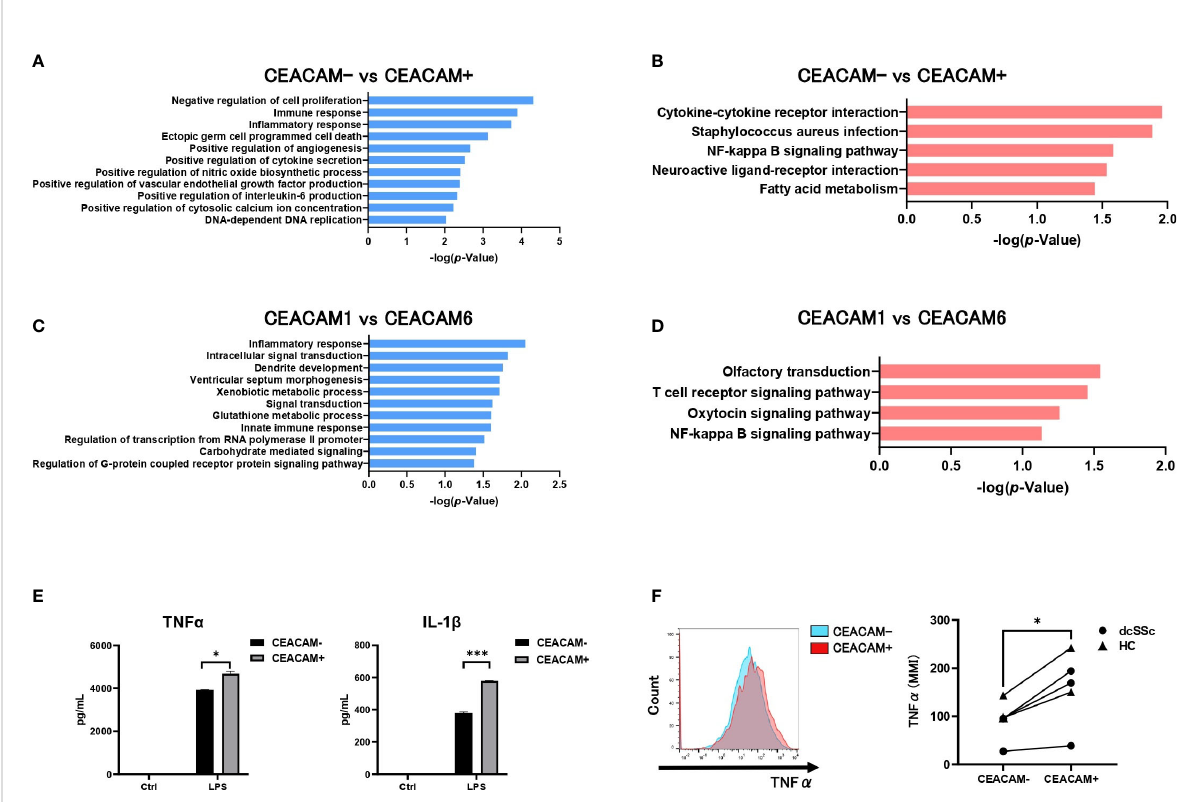
FIGURE 5 CEACAM-positive monocytes present with an in fl ammatory phenotype. The GO functional category analysis (A) and the KEGG pathway functional classi fi cation (B) of genes differentially expressed in CEACAM+CD14+16- monocytes and CEACAM-CD14+16- monocytes from a patient with dcSSc. DAVID v6.7 functional annotation bioinformatics microarray analysis software was used to obtain the GO biological process functional category and the KEGG pathway functional classi fi cation. Only GO and KEGG pathway terms for categories that showed statistically signi fi cant differences are shown ( P -value ≤ 0.01 in A or P -value ≤ 0.05 in B). GO functional category analysis (C) and KEGG pathway functional classi fi cation (D) of genes differentially expressed in CEACAM6+CD14+16- monocytes and CEACAM1+CD14+16- monocytes. Only GO and KEGG pathway terms with P -value ≤ 0.05(C) or P -value ≤ 0.1(D) are shown. (E) ELISA assay for the secretion of TNF- a and IL-1 b by CEACAM +CD14+16- and CEACAM-CD14+16- monocytes treated with LPS (50 ng/mL) for 6h. Data are expressed as the mean ± SD, and P values